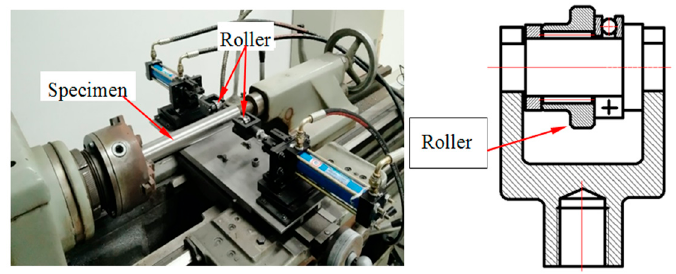
Figure 2. Photograph of the rolling device.